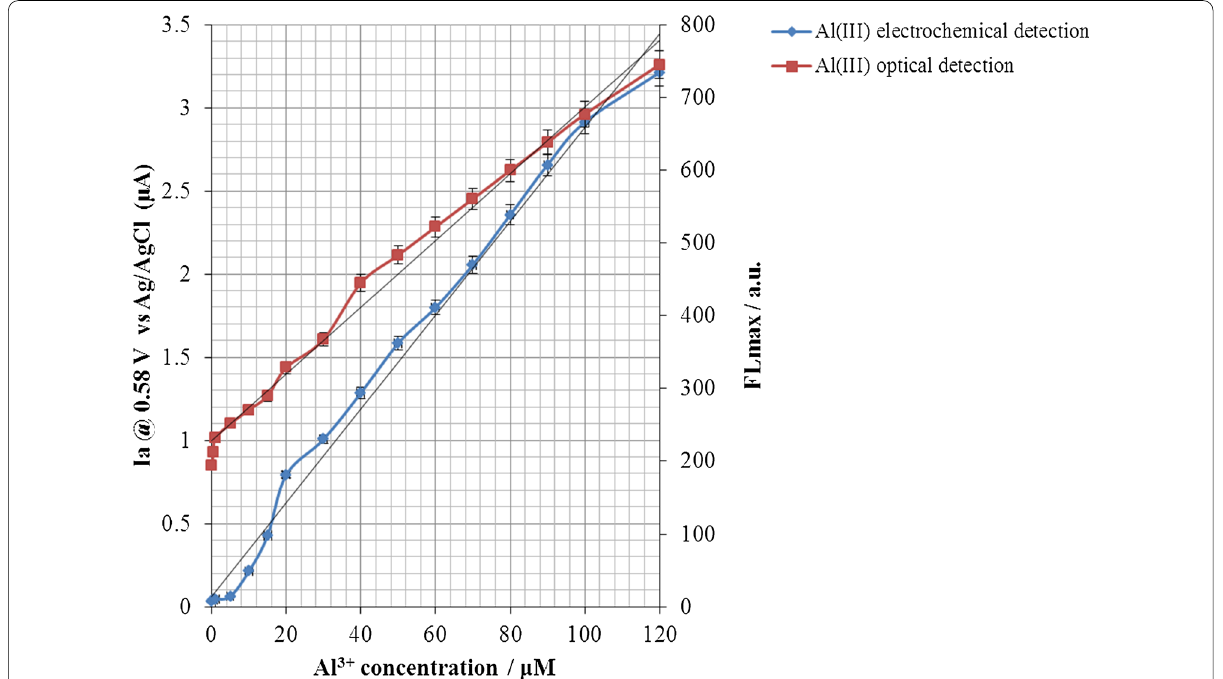
Fig. 13 The electrochemical /optical response changes of the electrochemical sensor to the changes in Al 3 +